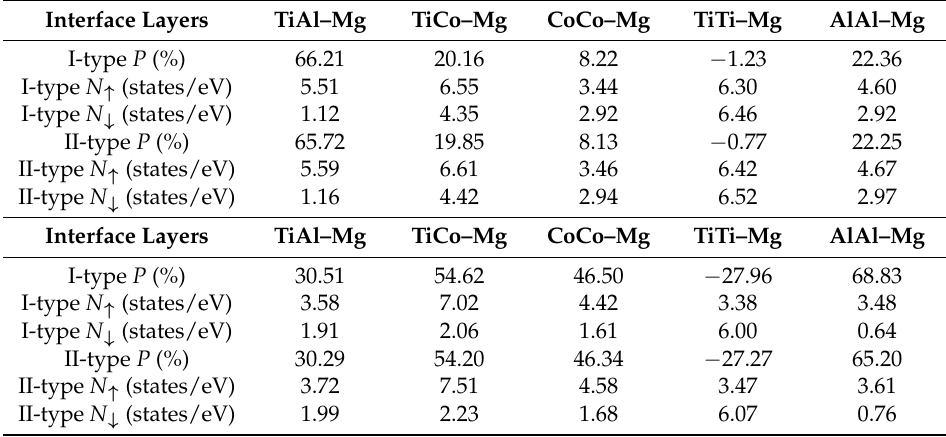
Table 3. Spin polarization P , spin-up state density N ↑ at the Fermi level, and spin-down state density N ↓ at the Fermi level. I-type includes the interface and subinterface layers in Ti 2 CoAl, while the II-type comprises I-type layers and the interface layer in MgO.